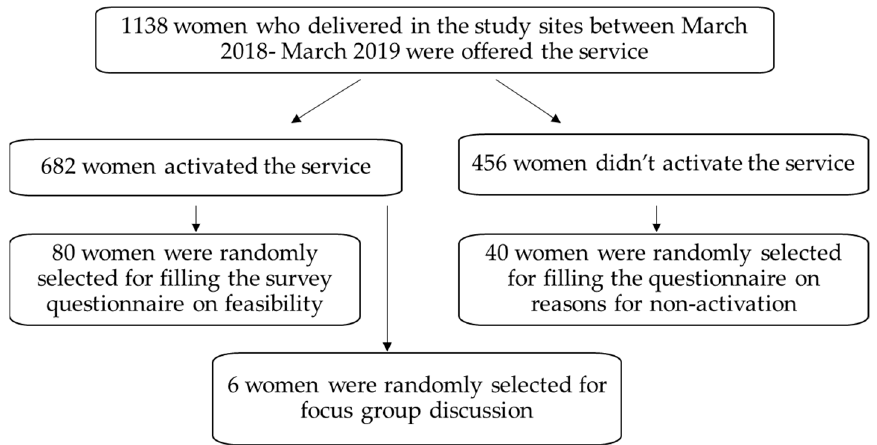
Figure 1. Study flow.